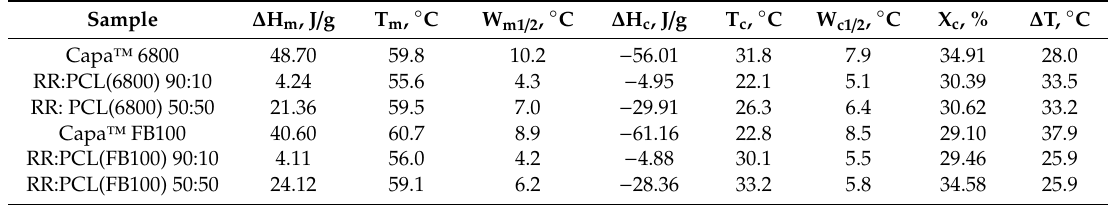
Figure 9. Di ff erential scanning calorimetry (DSC) curves for the RR blended with (left side) Capa ™ 6800 and (right side) Capa ™ FB100. Table 5. Thermal properties and crystallinity of the RR / PCL blends.